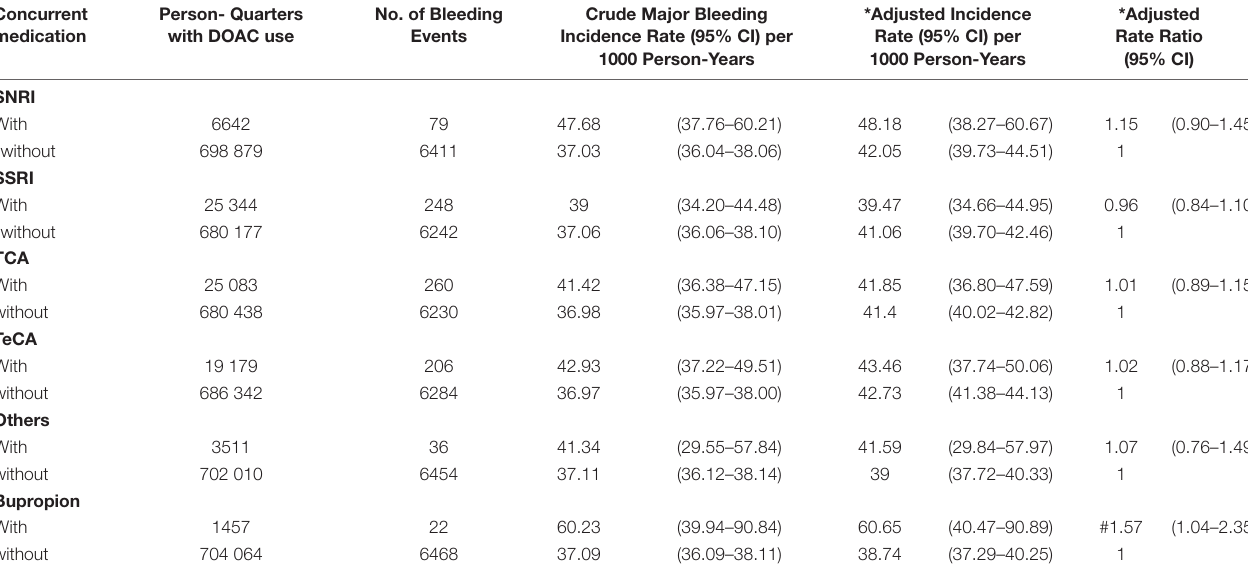
TABLE 5 | Risk of gastrointestinal hemorrhage among patients with AF taking DOACs with or without concurrent antidepressants. Concurrent Person- Quarters No. of Bleeding medication with DOAC use